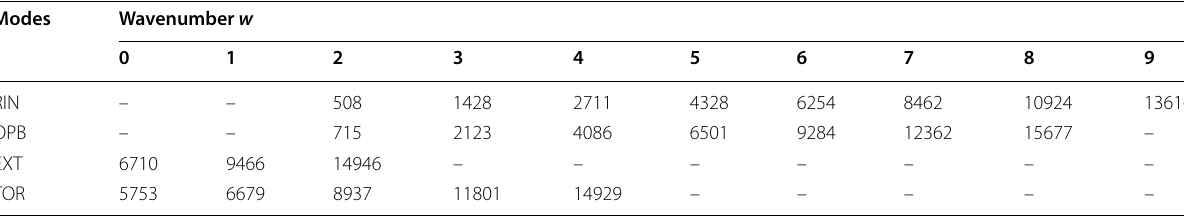
Table 9 Natural frequencies (Hz) Modes